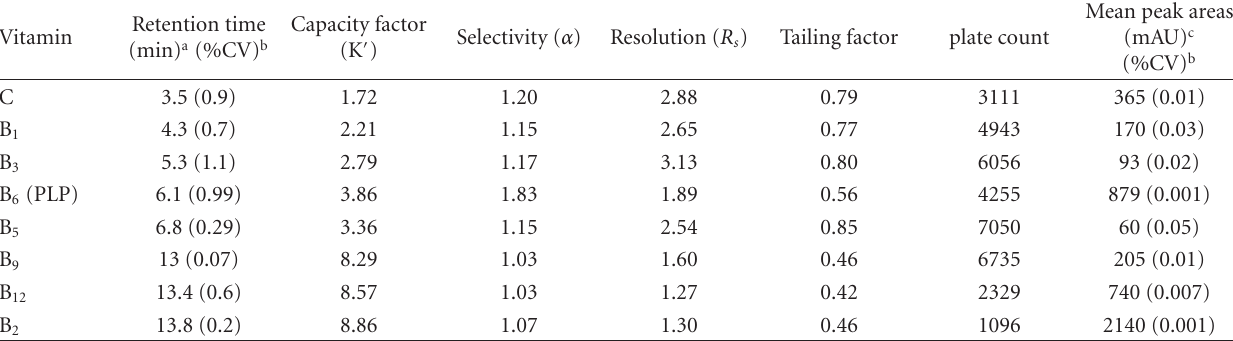
Table 2: System suitability test results for the optimised HPLC method for determination of water-soluble vitamins in biological matrices (column temperature = 30 ◦ C; flow rate = 0.2 mLmin − 1 ). Mean peak areas of 5 injections of aqueous standard solution containing 20ngmL − 1 of each water-soluble